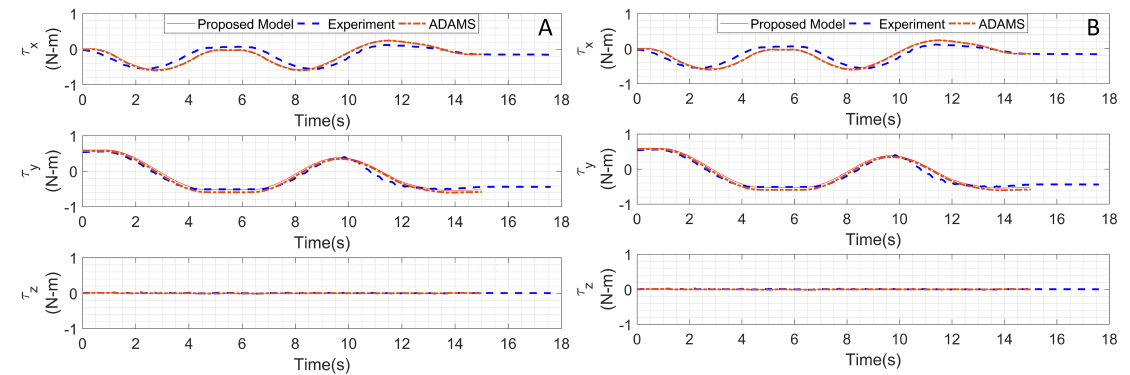
Figure 5. The torques generated at the base when the end effector is at the ( A ) lowest position ( B ) highest position along Link